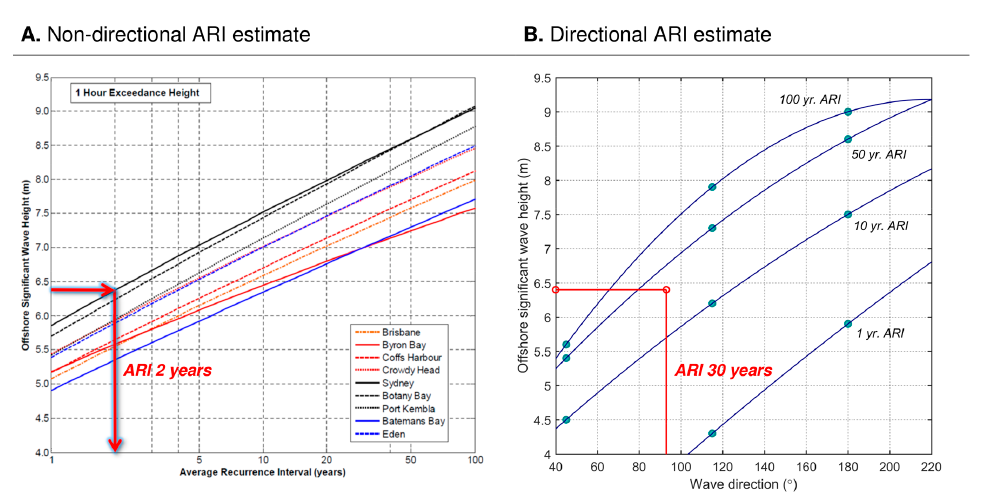
Figure 12. ( A ) Average Recurrence Interval (ARI) estimates for storm wave heights not accounting for wave direction. The peak storm wave height and ARI estimate for the June 2016 event are highlighted (red) for the Sydney buoy (black solid line). Original figure reproduced from [47]; ( B ) ARI estimates for storm wave heights at Sydney accounting for wave direction. Original data from [47].